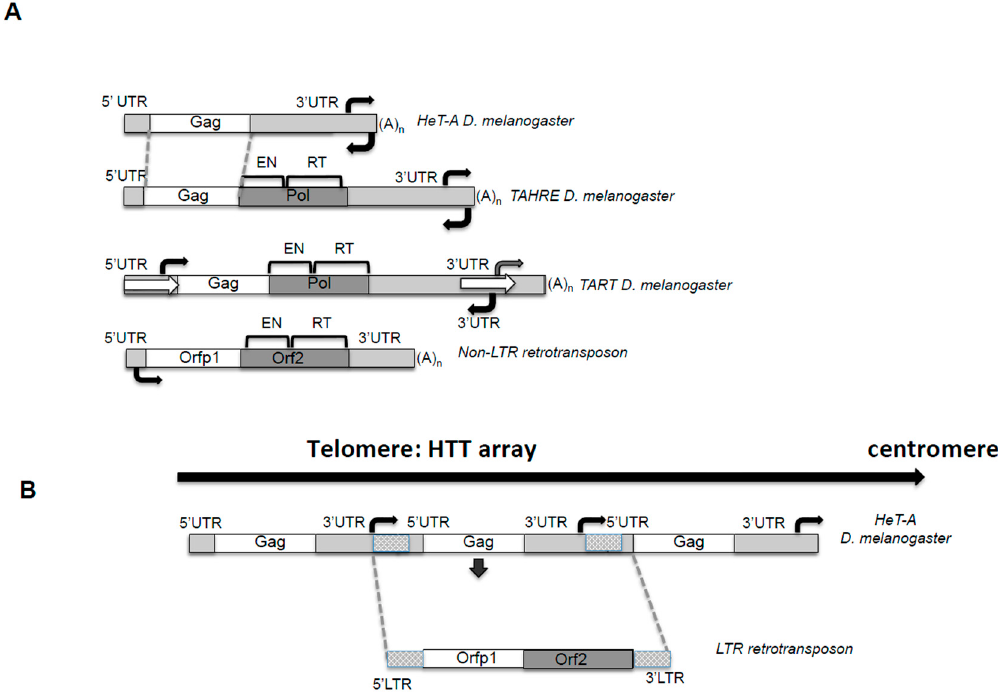
Figure 1. The telomeric retrotransposons of Drosophila. ( A ) The telomere retrotransposons. Figure 1 depicts the telomeric retrotransposons Healing Transposon ( HeT-A ), Telomere Associated and HeT-A Related ( TAHRE ) and Telomere Associated Retrotransposon ( TART ) from Drosophila melanogaster and a canonical non-Long Terminal Repeat (non-LTR) retrotransposon for comparing the unusual features of the telomere retrotransposons. Figure 1 is drawn approximately to scale. Dotted grey lines show conserved regions of TAHRE and HeT-A DNA sequences. Bright Grey: non-coding 5 (cid:48) and 3 (cid:48) untranslated regions (UTRs) sequences. White: Gag open reading frames (ORF). Dark Grey: Pol ORF domains; EN, endonuclease, RT, reverse-transcriptase. White arrows in TART indicate the Perfect Non-Terminal Repeats (PNTRs); (A)n, 3 (cid:48) oligo A. Black Arrows: indicate approximate location of the sense and antisense promoter. ( B ) The HeT-A telomere retrotransposon resembles an intermediate between a non-LTR and a LTR retrotransposon. Representation of a Drosophila melanogaster telomere. The array of HeT-A elements shows how from sense to sense promoter its analogous to an LTR retrotransposon. See legend in A) for schematic representation.